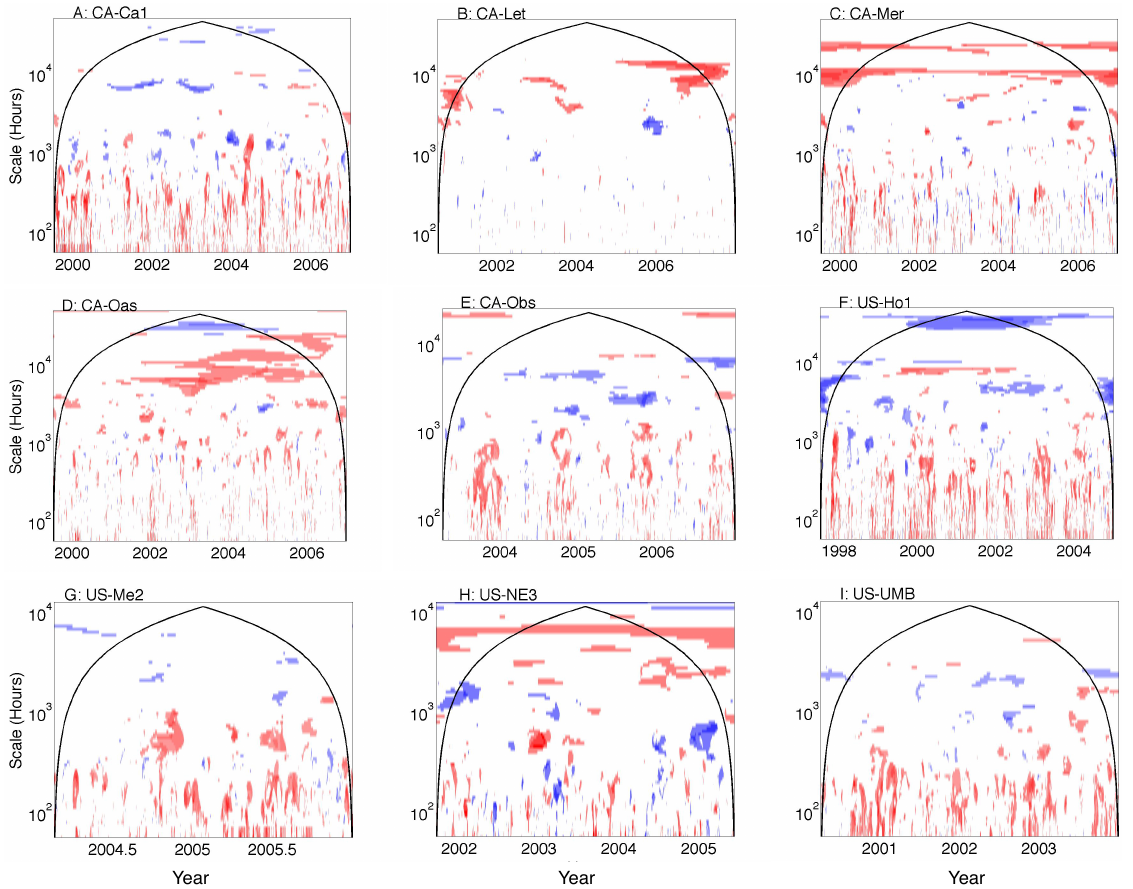
Fig. 8. The ratio of wavelet coherence significance tests for models that include or exclude foliar nitrogen (N). The color bar follows Fig. 5. Areas of dark blue represent times and scales for which models that incorporate N are significantly related to NEE measurements and models that exclude N are not significantly related to NEE measurements. Regions for which models that exclude N are significantly related to NEE measurements and those that include N are not are dark red. The color bar follows Fig.